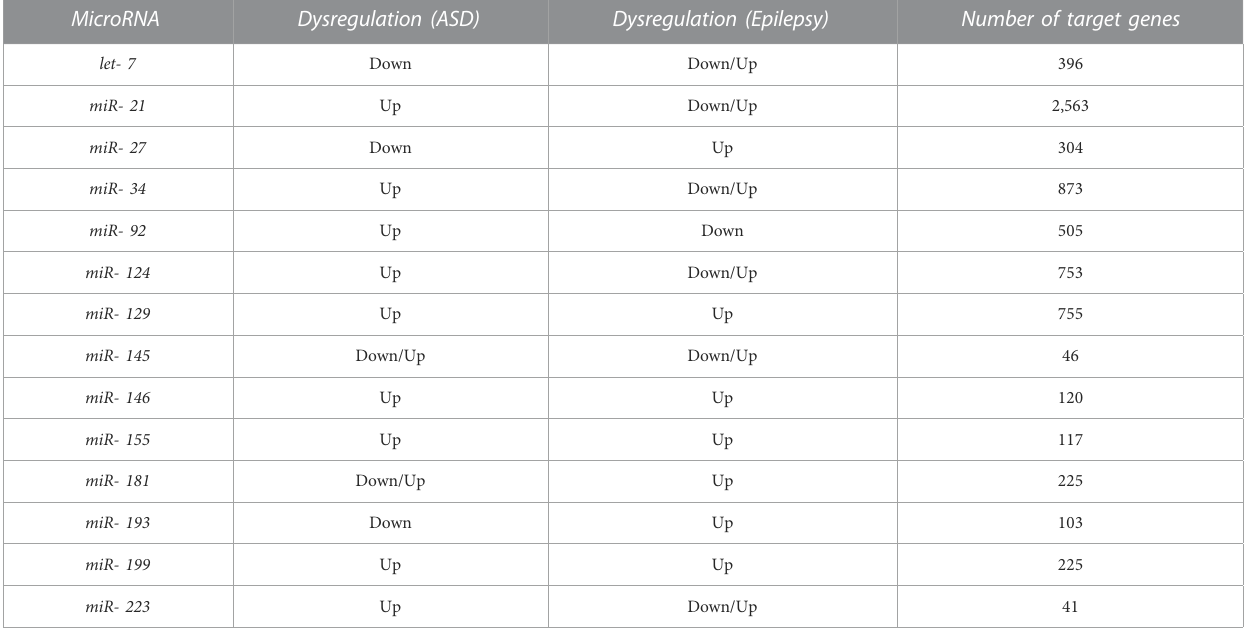
TABLE 1 Dysregulated miRNAs in both ASD and epilepsy and number of target genes regulated by each miRNA. The reported miRNAs were identi fi ed after a systematicliteraturesearchandincludedallthemiRNAswhoseexpressionlevelssigni fi cantlydifferedbetweencasesandcontrolsinbothdisordersinatleasttwo independent studies (Figure 1, Supplementary Data Sheet S3). The target genes database was obtained with the miRNAtap R